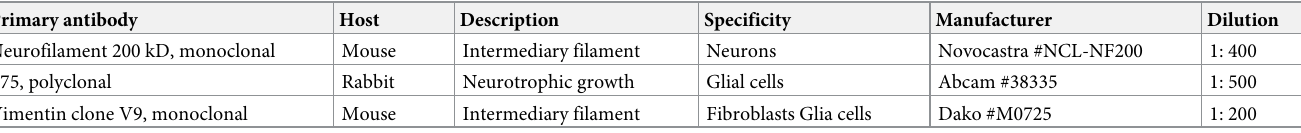
Table 2. Primary antibodies for immunostaining of cell specific antigens in the SG cells.